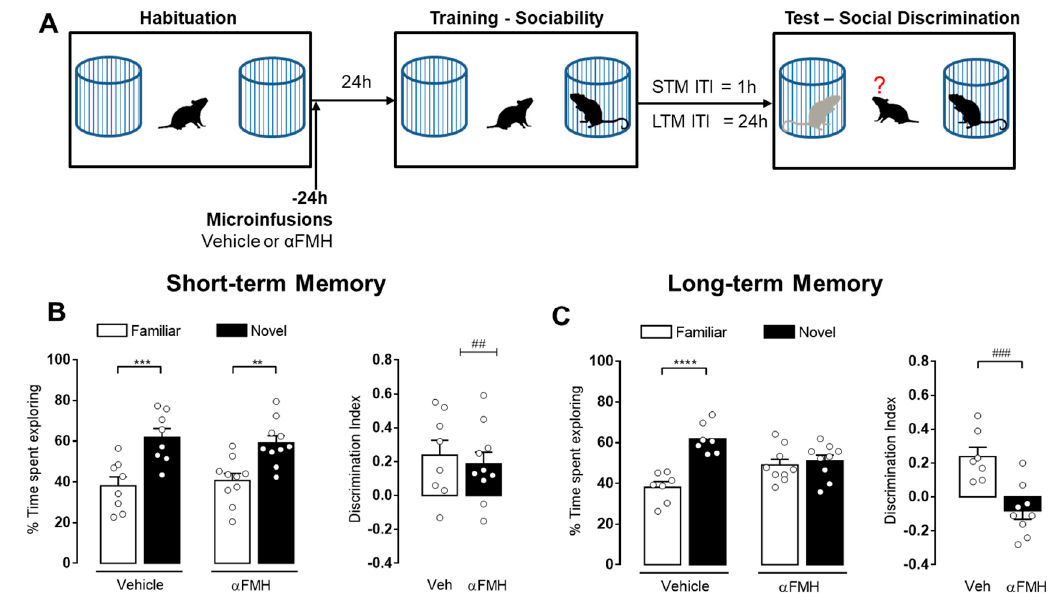
Figure 2. Impact of acute histamine depletion on short- and long-term social recognition memory. ( A ) Schematic drawing showing the sequence of the behavioral procedures. α FMH (5 µ g) or vehicle were injected directly into the lateral ventricles of Hdc +/+ male mice immediately after habituation. Retention test sessions were performed 1 h ( B ) or 24 h ( C ) after training. Shown are means ± S.E.M. of 7–10 animals per experimental group. **** p < 0.0001, *** p < 0.001, ** p < 0.01 by two-way ANOVA and Bonferroni’s MCT; ### p < 0.001, ## p < 0.01 by unpaired t